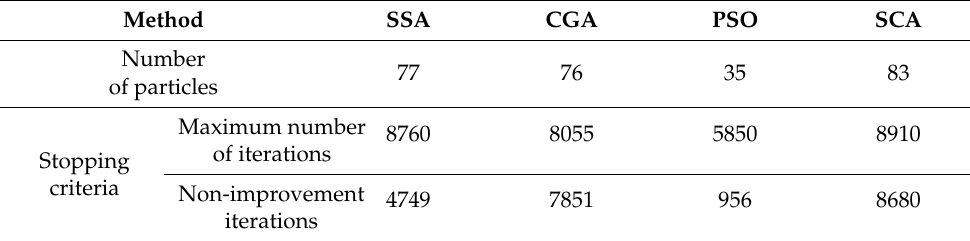
Table 4. Tuning parameters of the continuous methods used in this